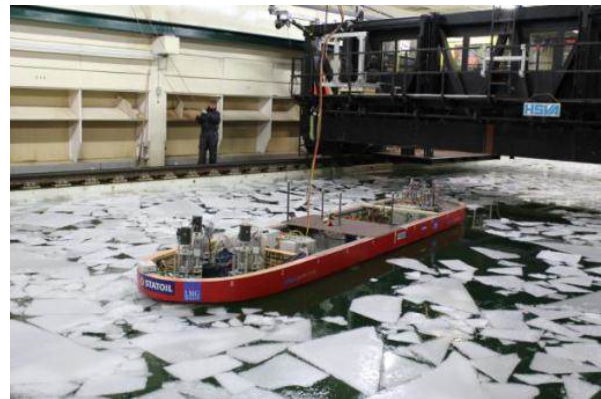
Figure 7: Statoil/LMG designed Arctic Drillship dur- ing free-floating DP model testing in the ice tank of HSVA. Courtesy: HSVA